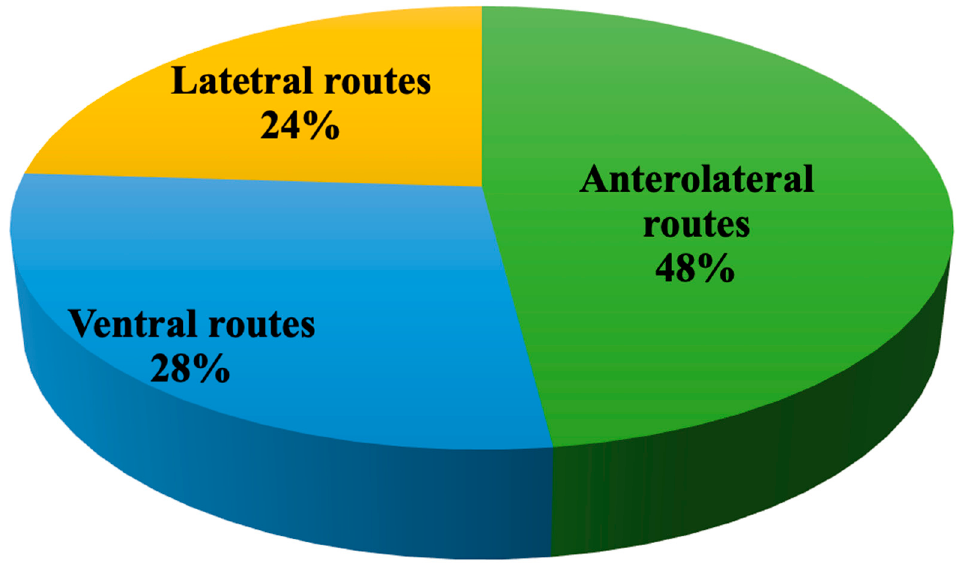
Figure 4. Distribution of papers addressing cavernous sinus meningiomas divided per surgical cor- ridor.